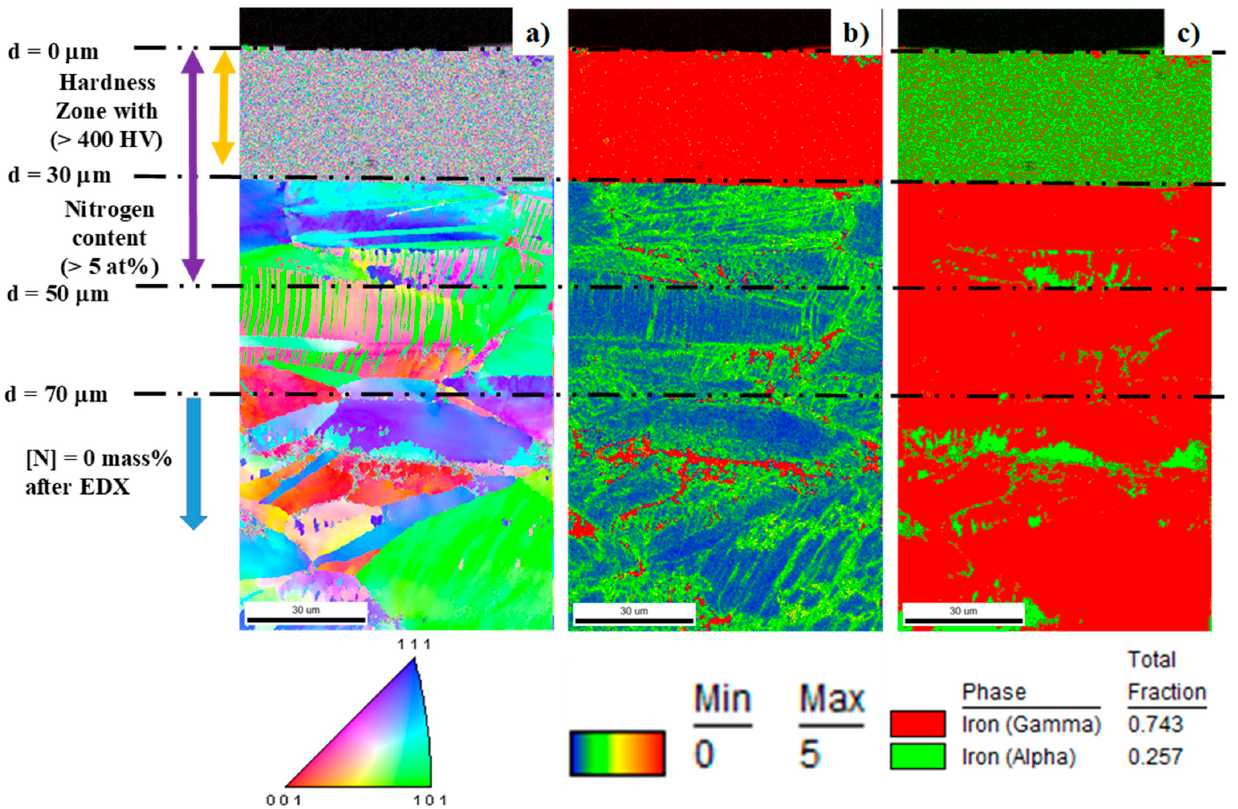
Figure 9. EBSD analysis on the microstructure at the cross-section of the nitrided AISI304 stainless steel substrate at 623 K for 14.4 ks after polishing and cleansing. ( a ) IPF profile, ( b ) KAM distribution, and ( c ) phase mapping.